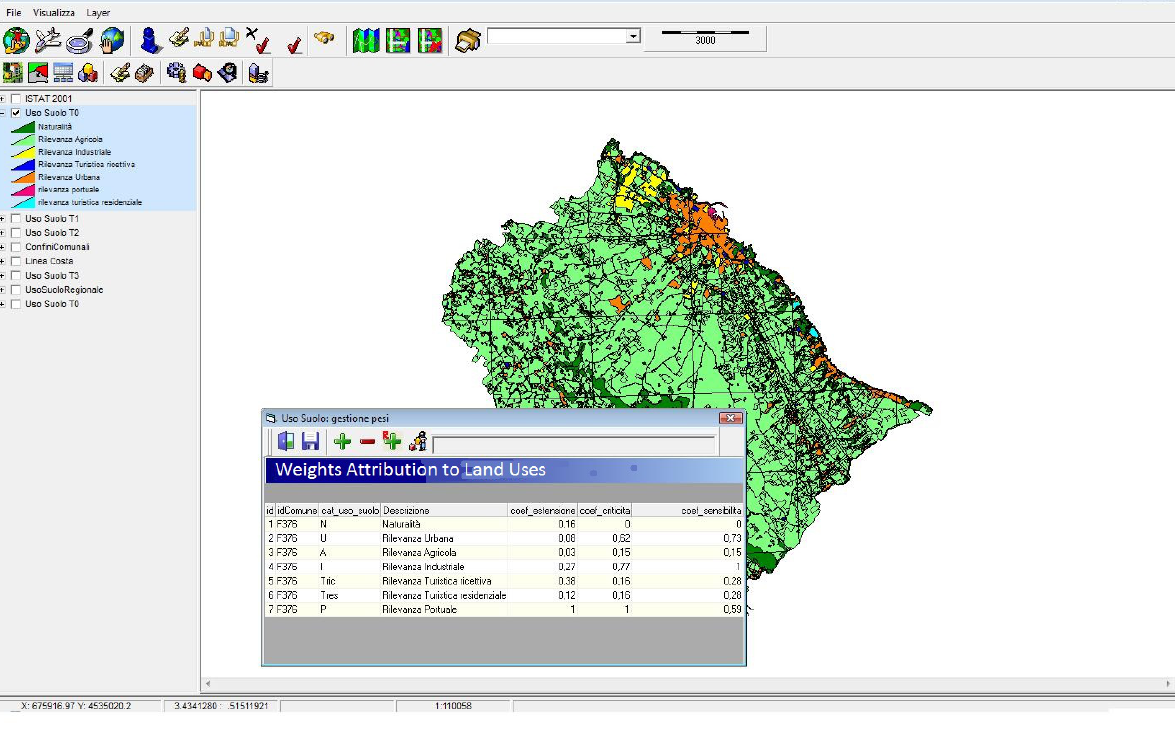
Fig. 3. Weighting according to criticality and sensitivity.